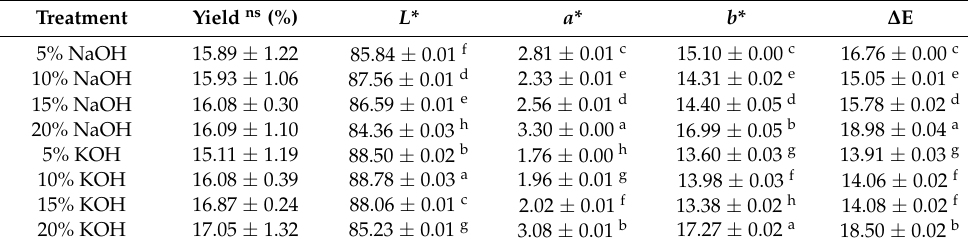
Figure 4. Energy dispersive X-ray (EDX) semiquantitative analysis for elemental estimation for hydroxyapatite extracted using 2% HCl 10 min ( a ), 5% HCl 10 min ( b ), 2% HCl 60 min ( c ), 5% HCl 60 min ( d ), 2% HCl 35 min ( e ), 5% HCl 35 min ( f ), 3.5% HCl 10 min ( g ), 3.5% HCl 60 min ( h ), 3.5% HCl 35 min Rep.1 ( i ), 3.5% HCl 35 min Rep.2 ( j ), 3.5% HCl 35 min Rep.3 ( k ), and the commercial hydroxyapatite ( l ). Table 4. The effects of alkali and concentration on hydroxyapatite precipitation.